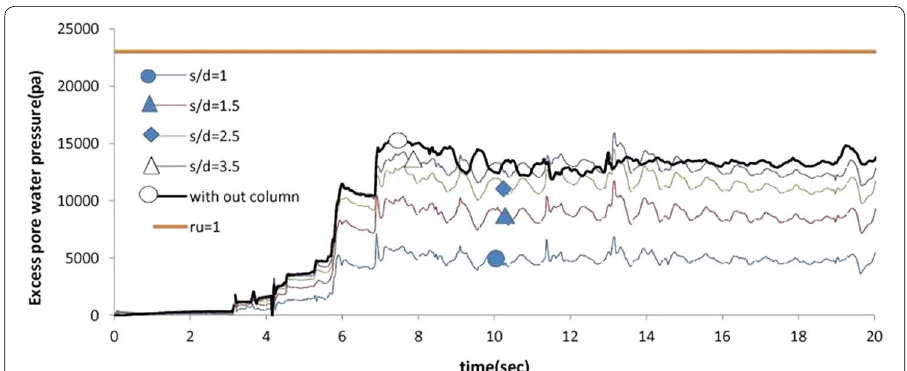
Fig. 9 Changes of excess pore water pressure at depth of 2.5 m